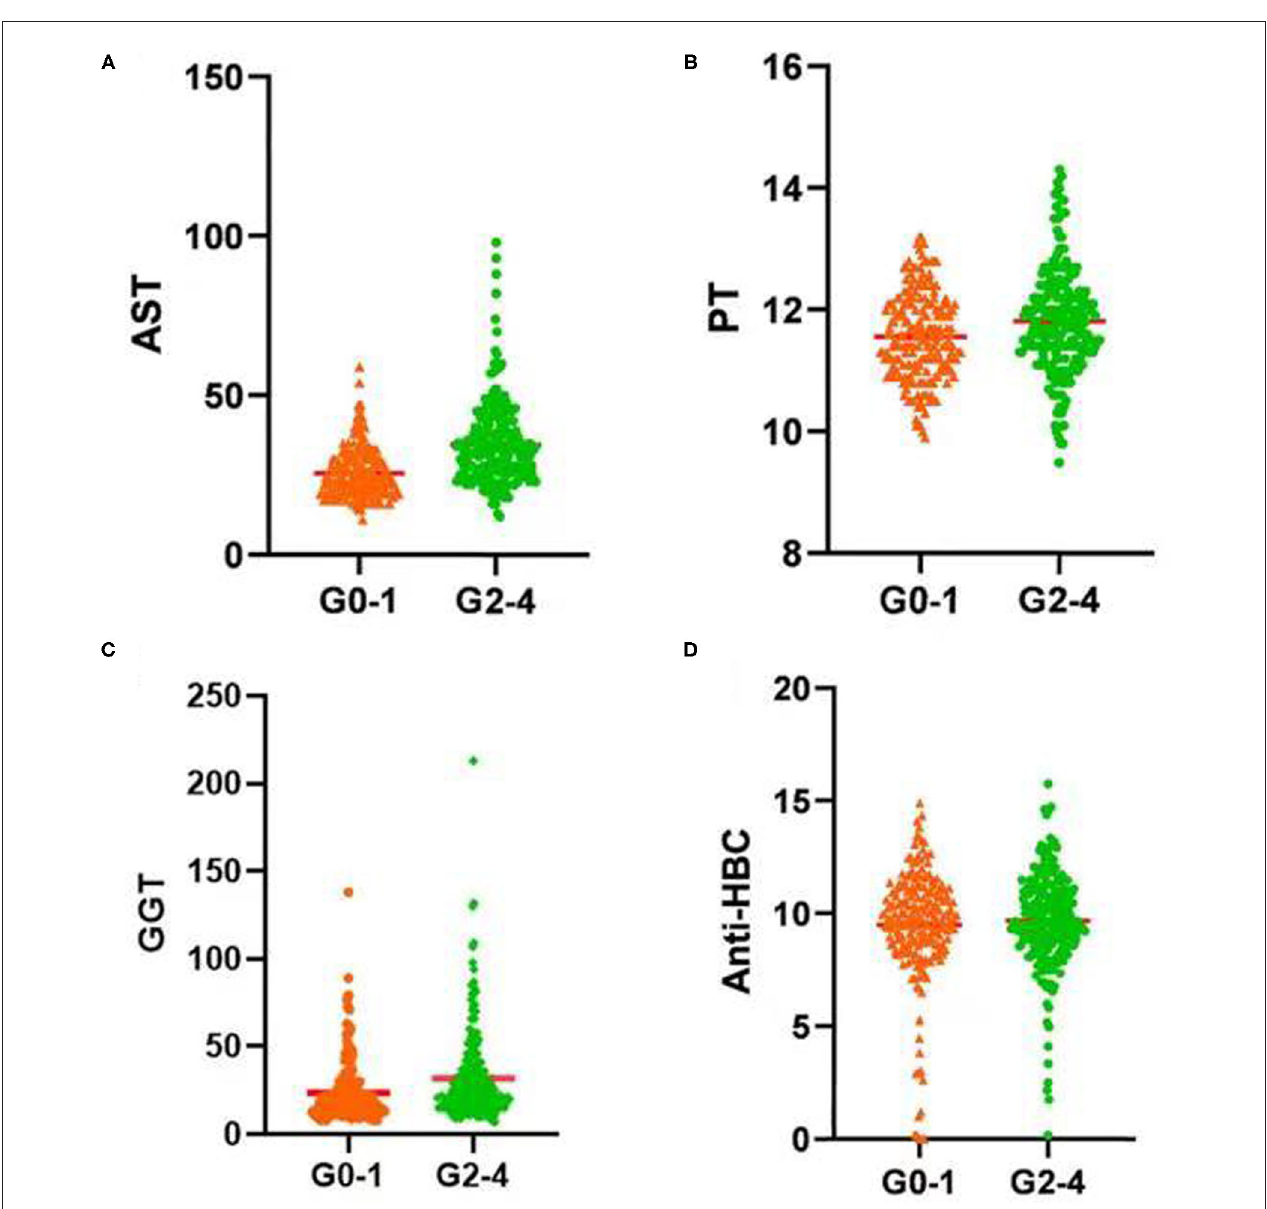
FIGURE 2 | Serum (A) AST level, (B) PT, (C) GGT level, and (D) Anti-HBC level increased significantly with increasing inflammation activity grade. AST, aspartate aminotransferase; PT, prothrombin time; GGT, glutamyl transpeptidase; Anti-HBC, anti-hepatitis B virus core antibody; G, inflammation grade. patients. Therefore, a model based on these four